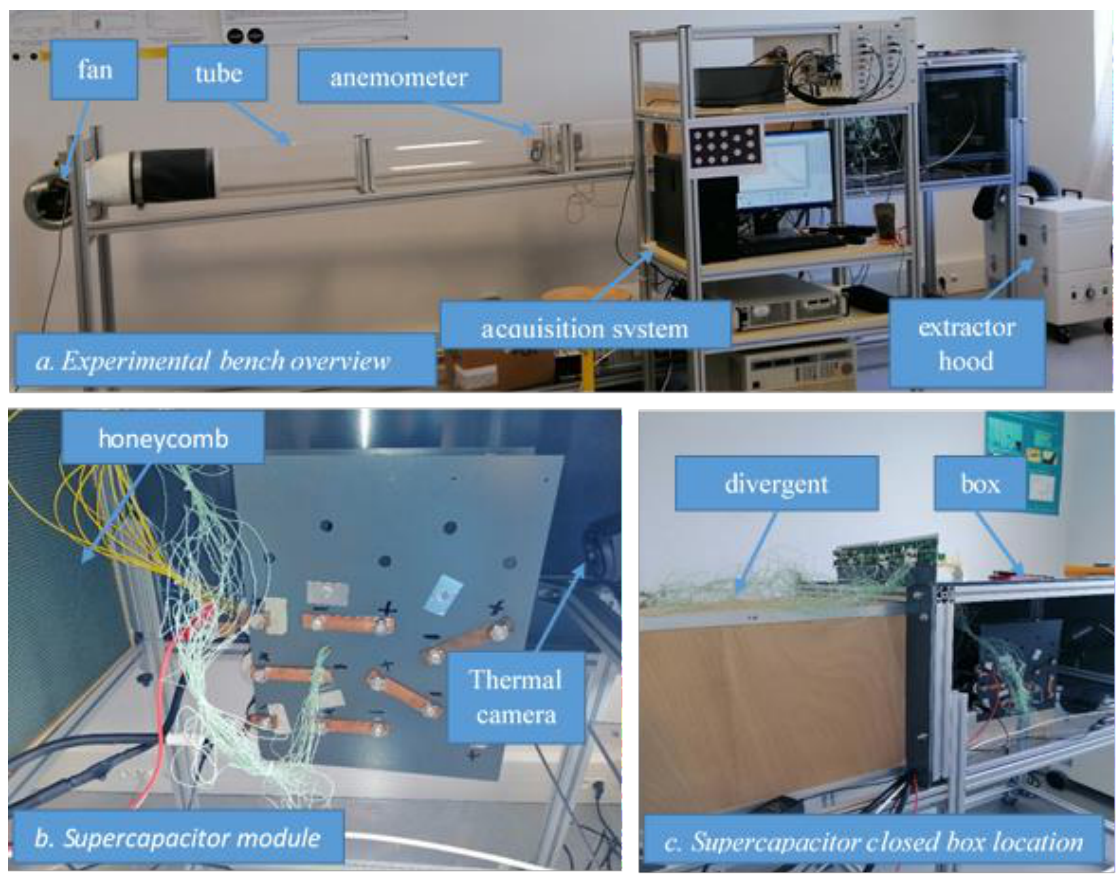
Figure 4. Test section. Table 2. Uncertainties on the measured